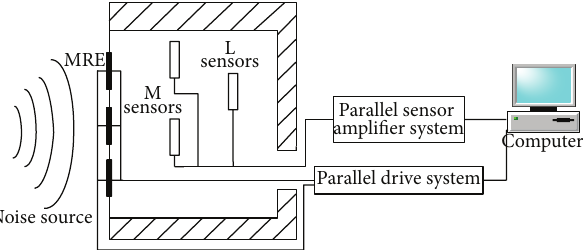
Figure 5: A sketch of the MRE noise control system.